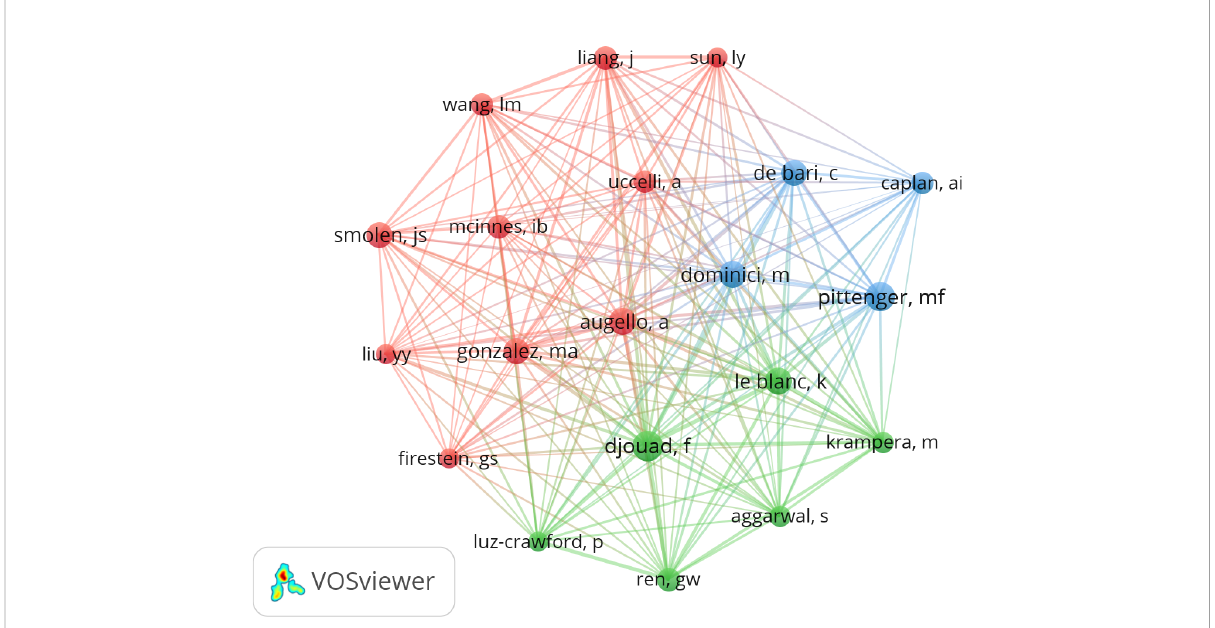
FIGURE 6 Visualization of Top 20 co-cited authors on research of MSCs and